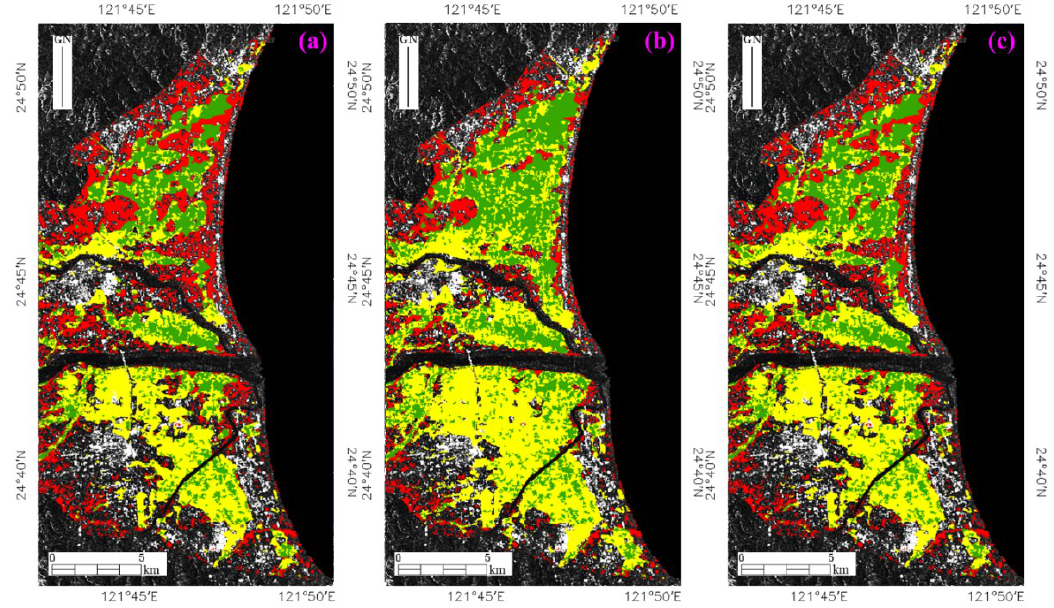
Figure 12. The flood extent map compared to different inundation potential maps. Yellow regions show the common areas between the flood extent map and the inundation potential map; green regions show the areas overestimated by the inundation potential map; and red regions show the areas underestimated by the inundation potential map. ( a ) Comparison of the flood extent map to 200 mm rainfall map in one day. ( b ) Comparison of the flood extent map to the one-year recurrence period inundation potential map. ( c ) Comparison of the flood extent map to the two-year recurrence period inundation potential